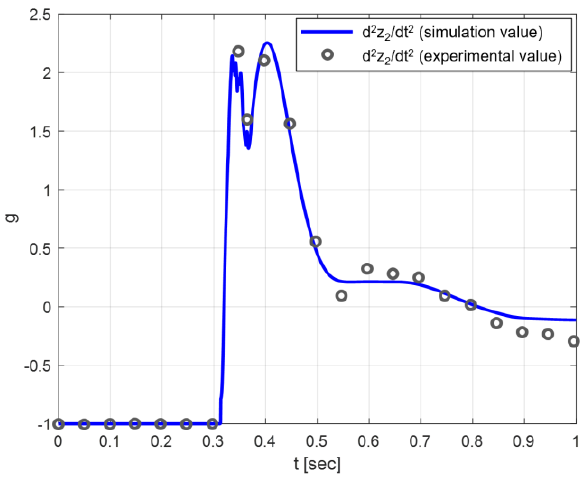
Figure 9. Time history of effective mass acceleration along vertical axis.